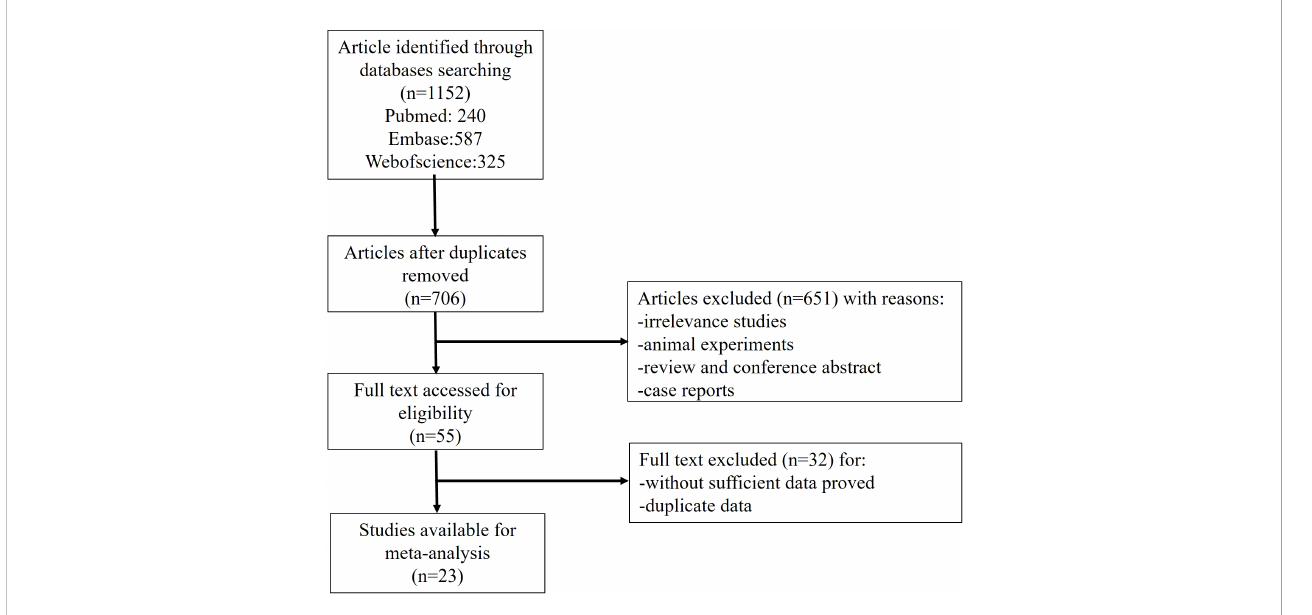
FIGURE 1 Flow chart of study